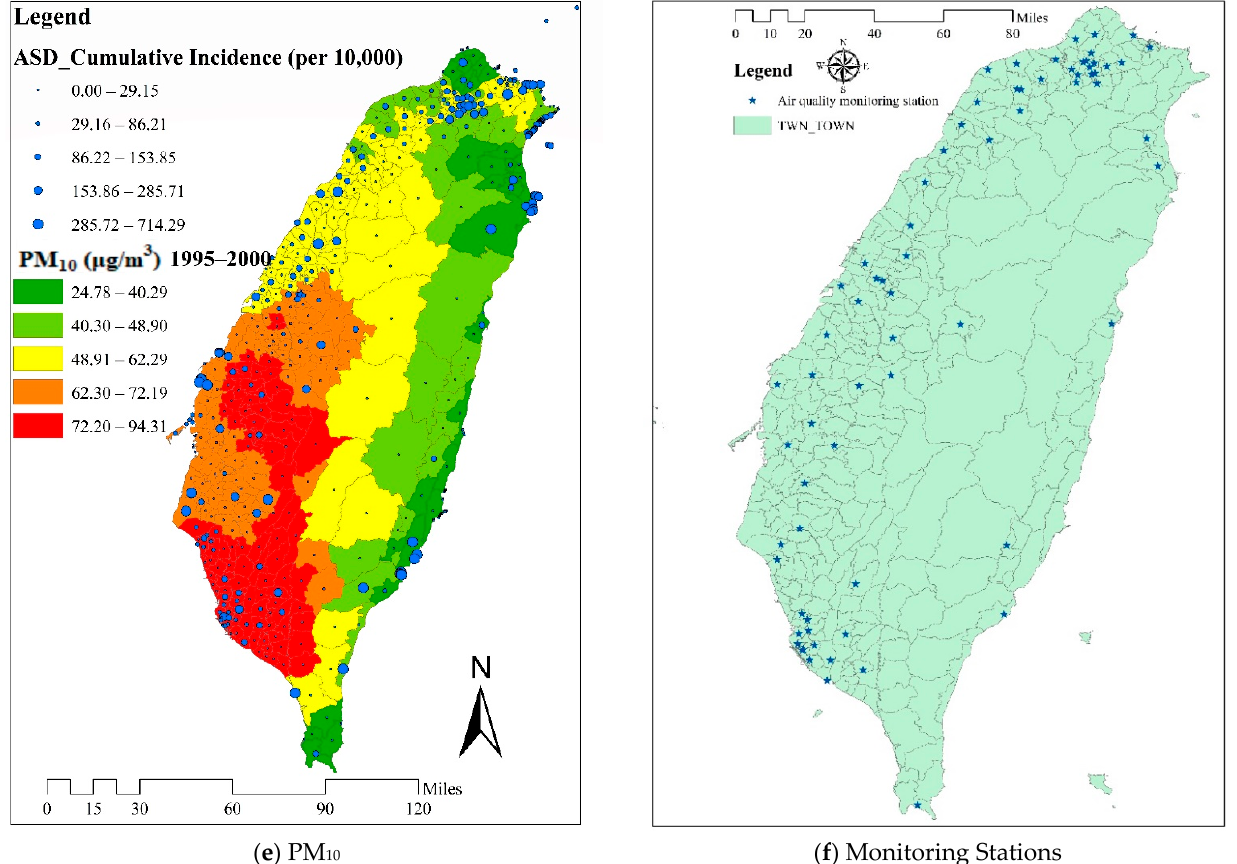
Figure 2. Cumulative incidence rates (per 10,000 children) of autism spectrum disorder and mean levels of air pollutants in Taiwanese townships during the study